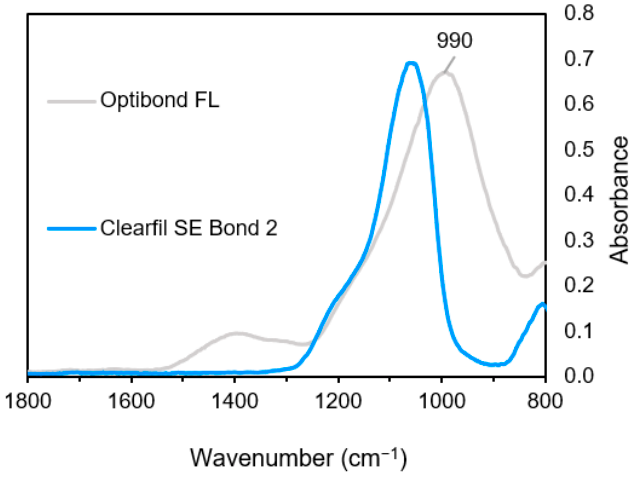
Figure 5. FTIR spectra of fillers retrieved from the adhesives (1800–800 cm − 1 ).